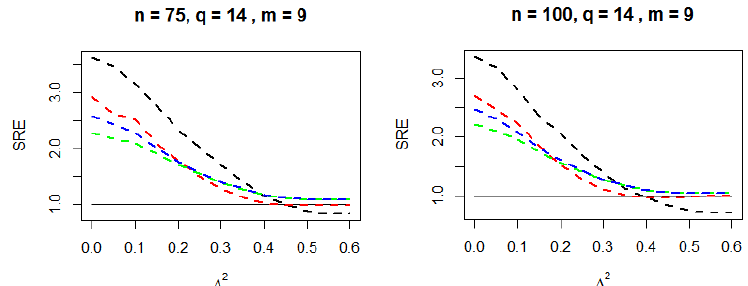
Figure 4. SRE of the restricted, pretest and shrinkage estimators with respect to ˆ θ U when ( m , q ) = ( 9,14 ) and for different sample